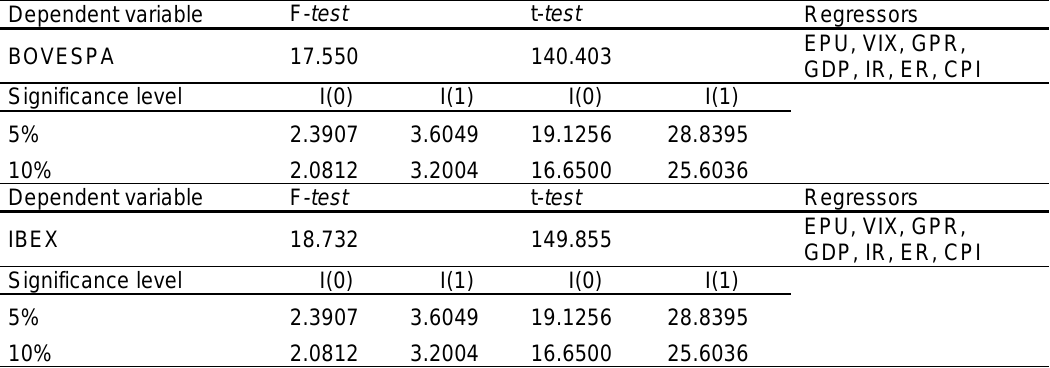
Table 3. PSS test. Dependent variable F-